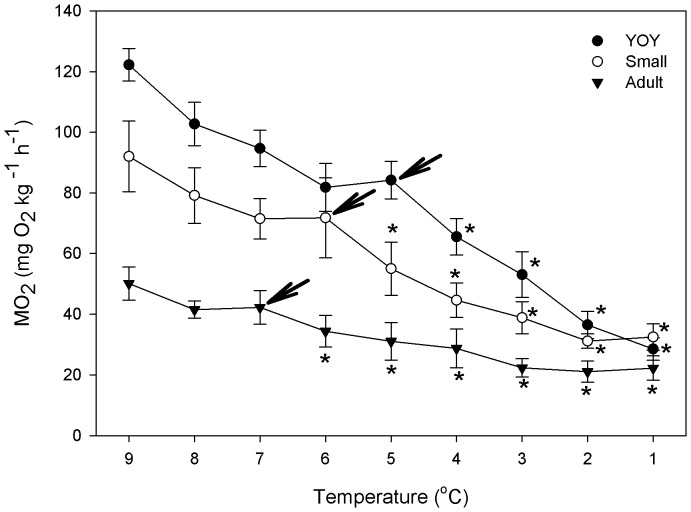
The effect of decreasing temperature at 2°C day−1 on oxygen consumption (MO2) of young-of-the-year (YOY), small and adult (large) cunner.A repeated measures one-way ANOVA, followed by Dunnett's post-hoc tests (P<0.05), was used to identify significant differences (*) in MO2 between the acclimation temperature (9°C) and the other temperatures within each size class. The arrows indicate the temperature at which a rapid decrease in MO2 was initiated for each size class. Values are mean ±1 S.E. (N = 7 - 8 for each size class).